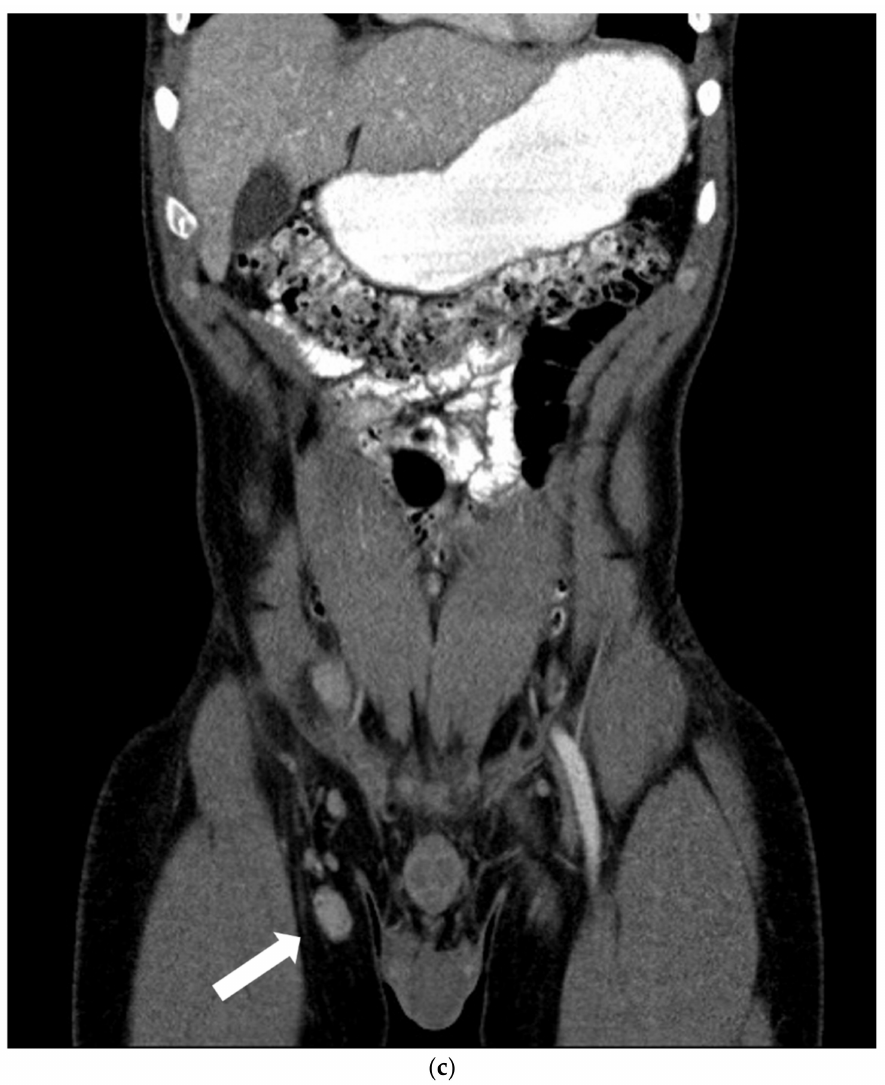
Figure 2. Contrast-enhanced computed tomography with axial ( a ) and coronal ( b , c ) reconstructions in the venous phase. ( a , b ) The thin arrow shows, both on the axial and coronal image, the hyper vascular right iliac lymphadenopathy. ( c ) The coronal image shows several right hyper vascular inguinal lymphadenopathies. The larger in size was selected for biopsy (thick arrow). An abdominal MRI was integrated into the examination. The MRI was performed with 3T equipment, using T1 weighted, T2 weighted, and DWI weighted sequences without intravenous contrast: the iliac and inguinal lymphadenopathies showed high signal at DWI weighted sequences and low ADC signal, features of hypercellular tissues, thus suggesting either an inflammatory or a neoplastic nature (Figure 3). The patient was then referred to a hematological clinical evaluation. The physical examination showed an inguinal palpable lymph node and abdominal pain in the right iliac fossa. Blood tests showed a slight increase of neutrophil granulocytes CRP, fibrinogen, alpha and gamma-globulines, suggesting that inflammation was